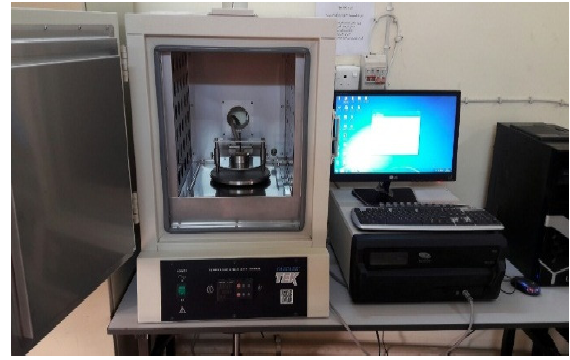
Fig. 10. Hot disk apparatus.